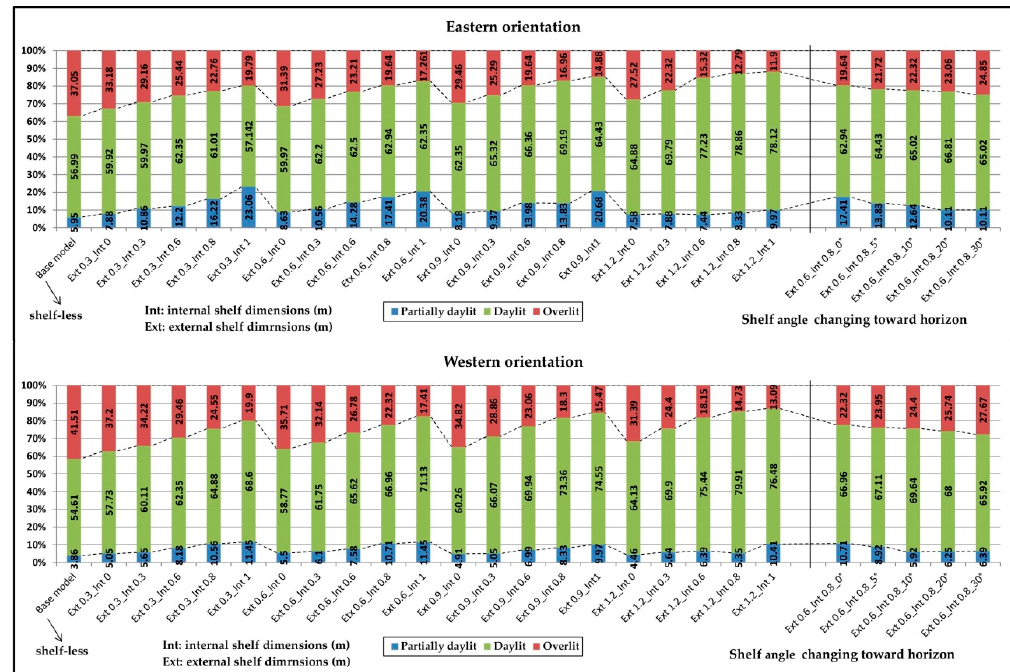
Figure 5. The results of daylight availability analysis for the eastern and western orientations of the light shelf in the three mentioned intervals.